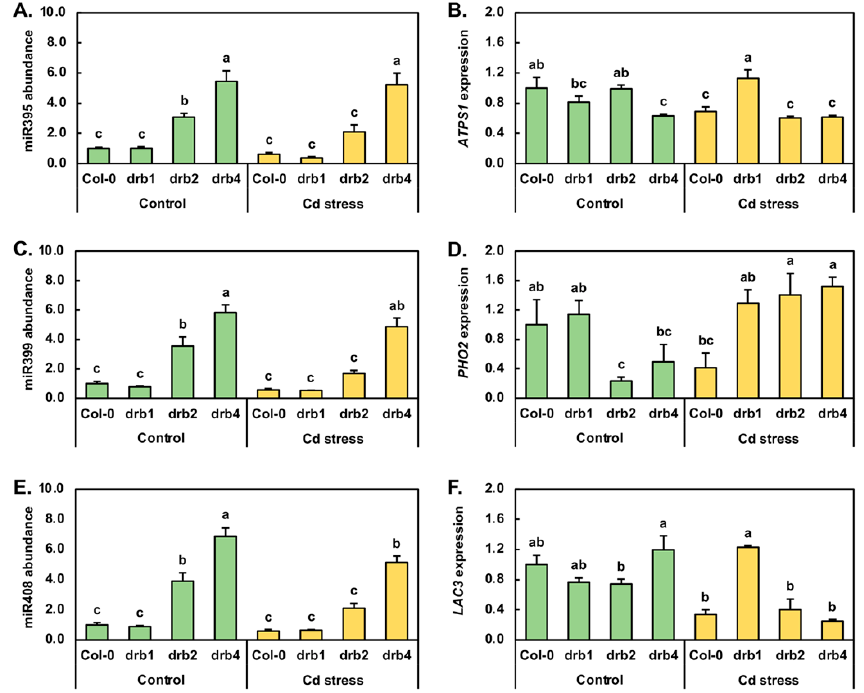
Figure 4. RT-qPCR quantification of the abundance of three Arabidopsis abiotic stress responsive microRNAs and the expression of their target genes in cadmium-stressed Col-0, drb1 , drb2 and drb4 seedlings. RT-qPCR assessment of miR395 abundance ( A ) and the expression of its target gene, ATPS1 ( B ), in control and Cd-stressed Col-0, drb1 , drb2 and drb4 whole seedlings. Quantification of the abundance of miR399 ( C ) and the expression of its target gene PHO2 ( D ) in Col-0, drb1 , drb2 and drb4 whole seedlings cultivated in either control conditions or a Cd-stress environment. RT-qPCR analysis of miR408 abundance ( E ) and the expression of its target gene, LAC3 ( F ), in 15-day-old control and Cd-stressed Col-0, drb1 , drb2 and drb4 whole seedlings. ( A – F ) Statistical data were ana- lyzed using one-way ANOVA and Tukey’s post-hoc tests. The statistically significant differences are indicated by a different letter ( p- value < 0.05) above each column of each histogram.